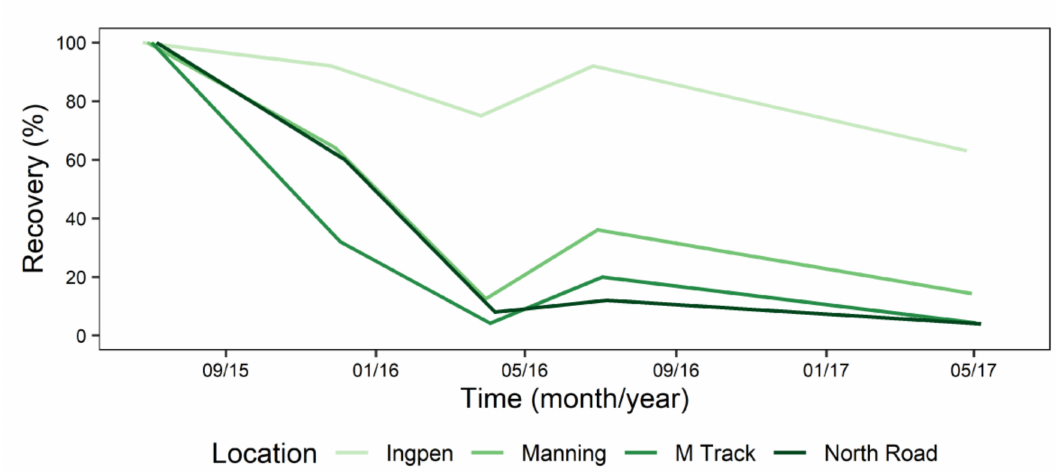
Figure 9. Mean recovery of Phytophthora cinnamomi from four bunds in the Myara location in Huntly minesite at 30 cm